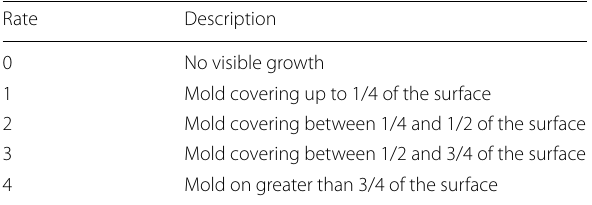
Table 2 Rating for the infection value of mold growth on bamboo